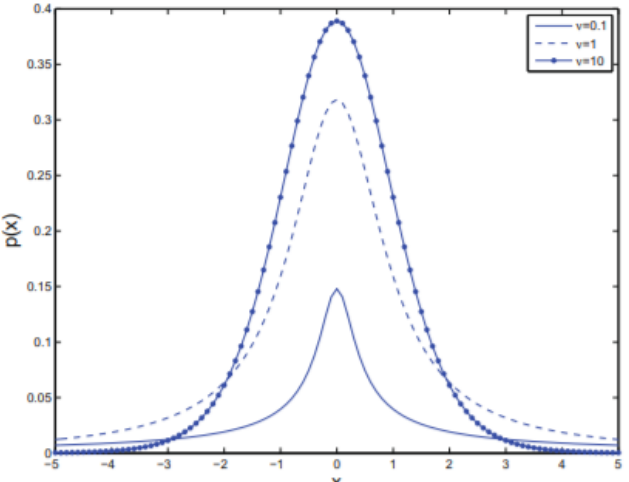
Figure 2. A Student’s t -distribution ( μ = 0, σ = 1) for various degrees of freedom. As ν - > ∞ the distribution tends to a Gaussian. For small values of ν , the distribution has heavier tails than a Gaussian [22].